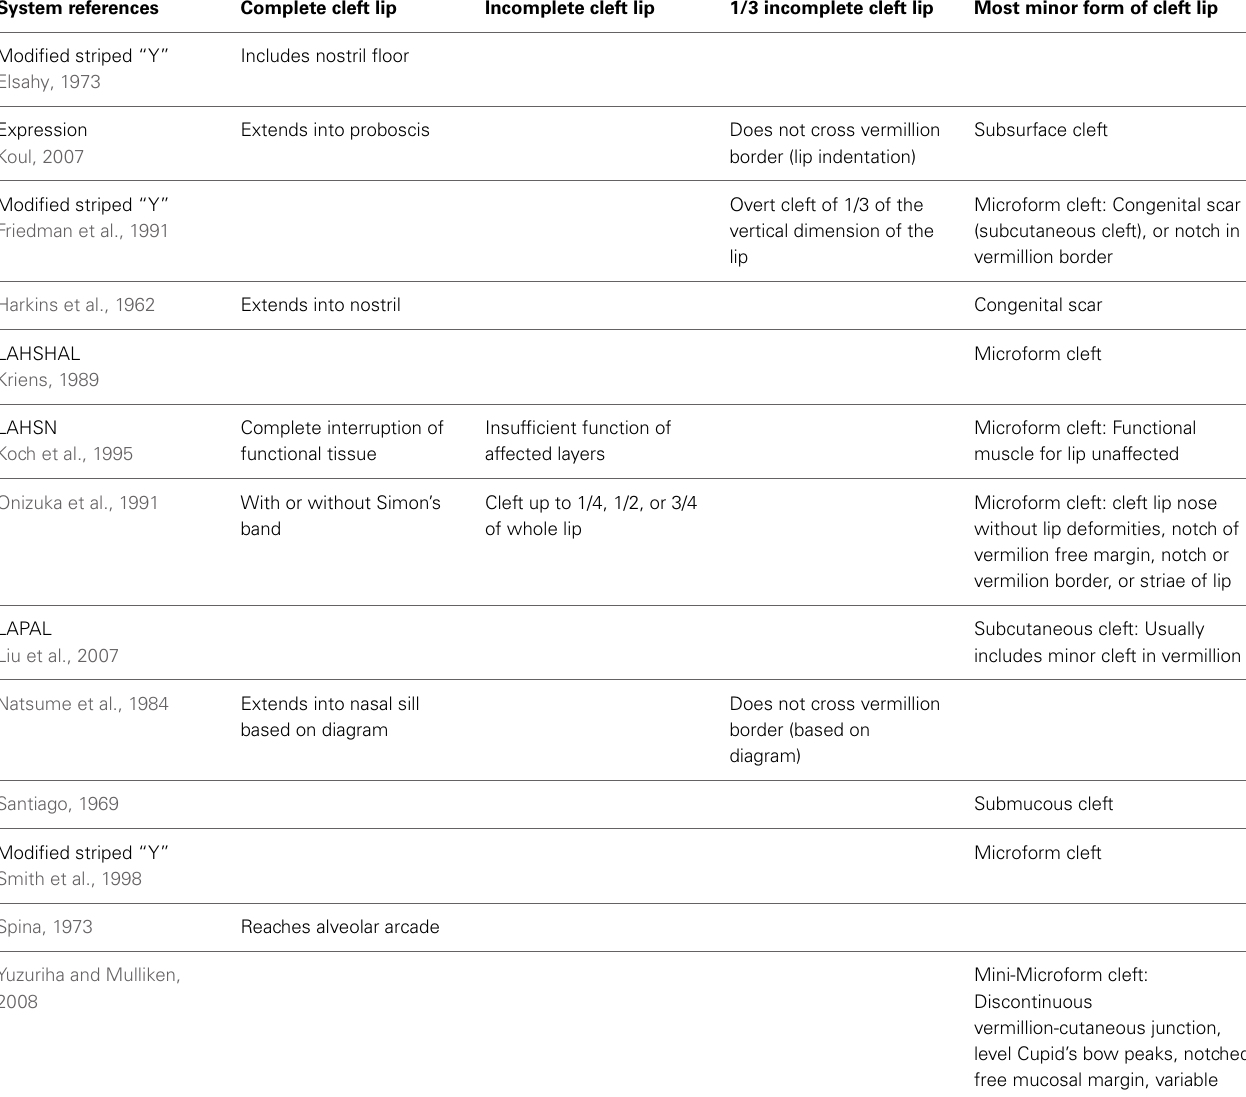
Table 4 | Examples of variation in definitions for common terms used to describe cleft lip *